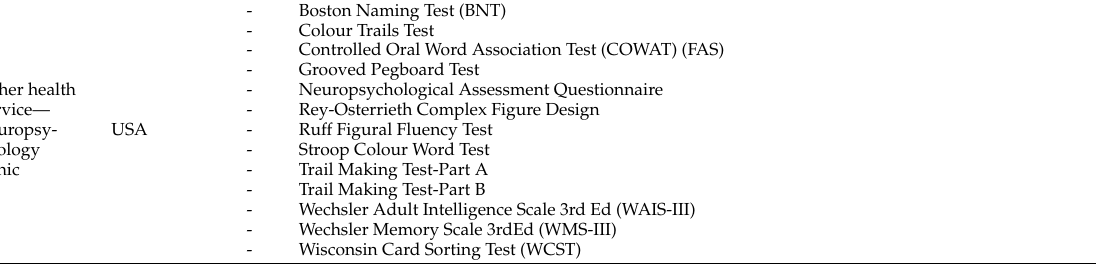
Boston Naming Test (BNT) - Colour Trails Test - Grooved Pegboard Test - Rey-Osterrieth Complex Figure Design - Ruff Figural Fluency Test - Stroop Colour Word Test - Trail Making Test-Part A